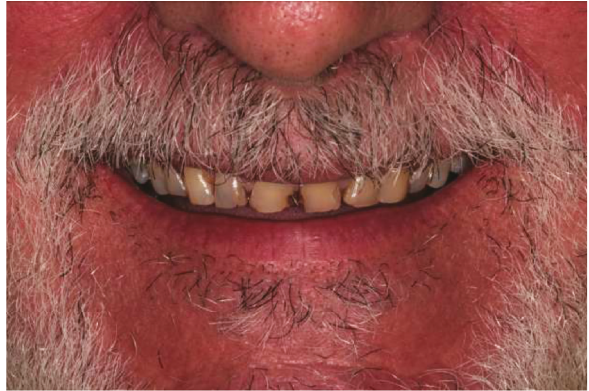
Figure 1: Smile (frontal view).